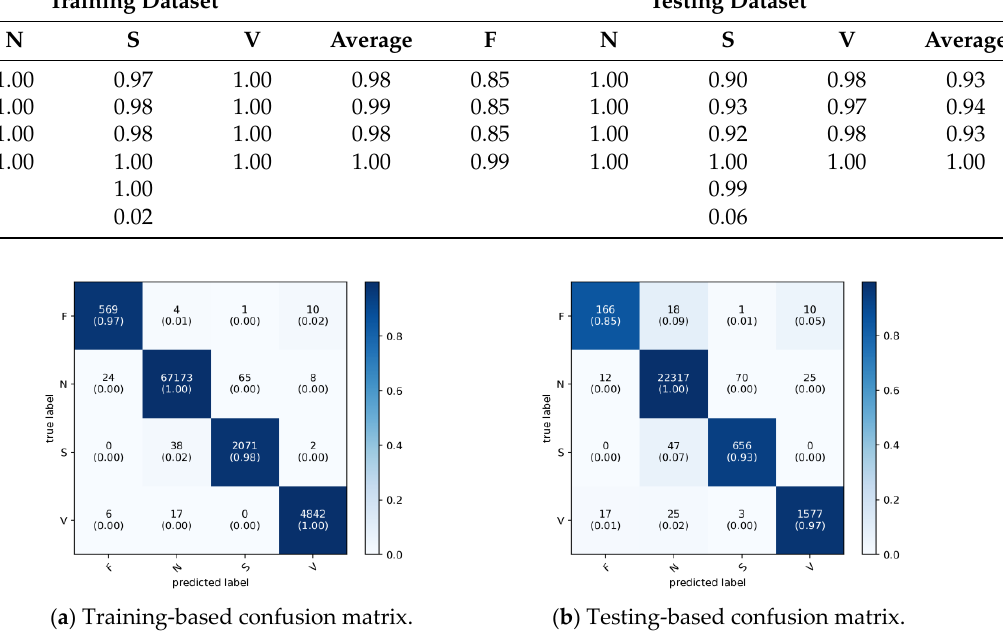
Figure 6. Confusion matrix of the 1D-CNN model for arrhythmia categorization. In the test dataset, the average of all classes decreased by 0.5 per cent in all classes compared to the training dataset, with overall 0.93, 0.94, and 0.93 precision, recall and f1- score, respectively. Class N is still in the lead with a perfect score in all performance matrices, while class V dropped 0.02 per cent in precision and f1-score and 0.03 per cent in recall. Class S dropped 0.07 per cent in precision, 0.05 per cent in recall and 0.06 per cent in F1-score. Even though the class weight technique has been applied to adjust the cost function of the model, class F is still the worst class, with 0.85 per cent in all classes with a 0.10 per cent drop. We can relate the low score of class F to the sample size, which only has 584 and 195 samples; among them, only 15 and 29 samples were misclassified in the training and testing datasets, respectively.